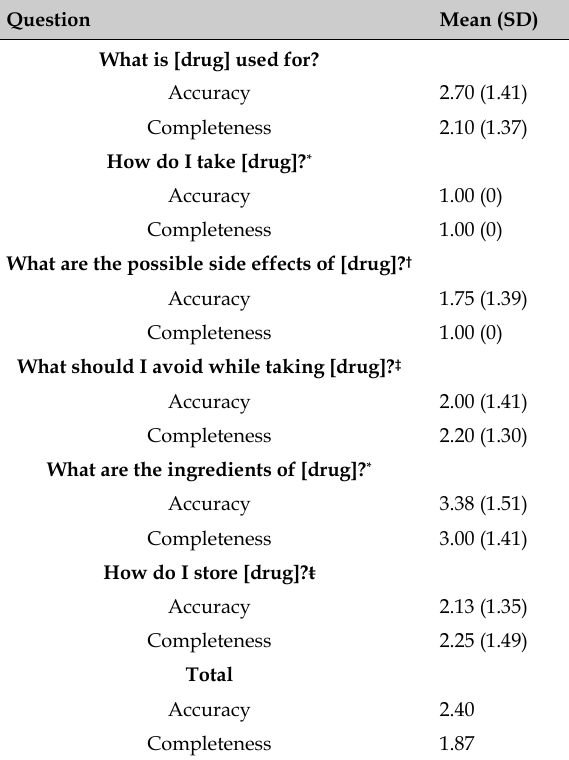
Table 3 Mean accuracy and completeness scores by